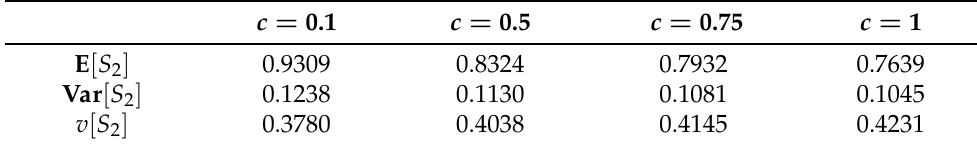
Figure 1. Reliability function with GW distribution of the components’ lifetime with v = 0.5227. Table 1. System reliability characteristics.